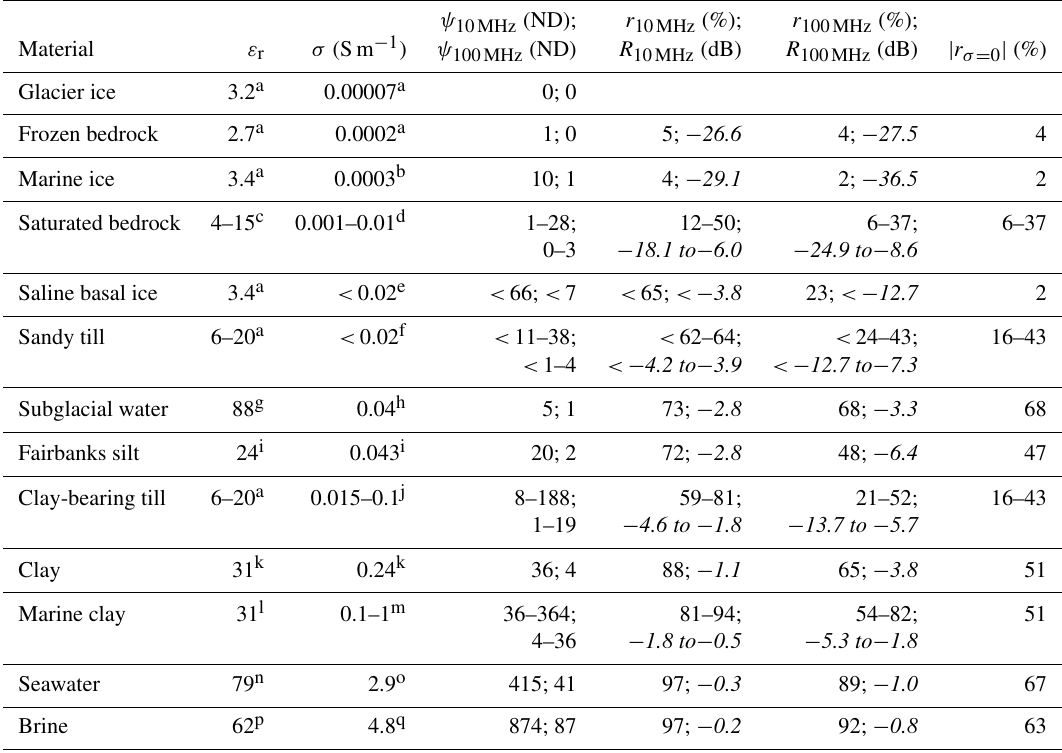
Table 1. We compile relative permittivity, ε r , and electrical conductivity, σ , for glacier ice and likely basal and subglacial materials. Whenever possible, the values are reported for temperatures close to the freezing point of freshwater and linear frequencies of tens to hundreds of megahertz. The permittivity and conductivity values are followed by the corresponding dimensionless control parameter ψ = σ/(εω) for 10 and 100MHz. For each basal and subglacial material, we also give the values of the amplitude reflection coefficient, r (Eq. 7b), and the power reflection coefficient, R (Eq. 9), for a specular basal interface at frequencies of 10 and 100MHz. R is in decibels, and r is in percent. The last column gives the absolute value of the frequency-independent r under the assumption of zero conductivity (Eq. 11). The values of the power reflection coefficient in decibels are given in the table in italics. ND stands for non-dimensional units. ψ 10MHz (ND); r 10MHz (%); r 100MHz (%); ε r σ (Sm − 1 ) ψ 100MHz (ND) R 10MHz (dB) R 100MHz (dB) | r σ = 0 |